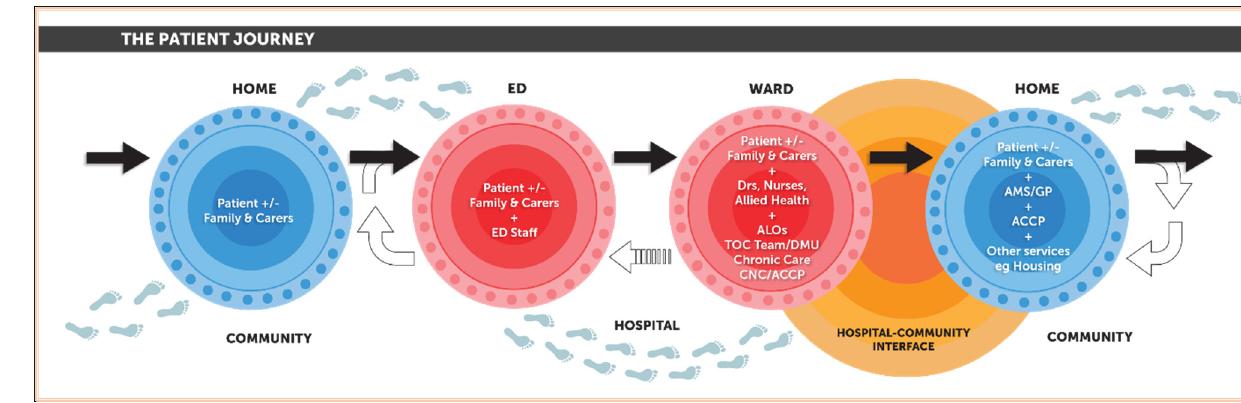
Figure 1. ATOC patient journey. ACCP, Aboriginal Chronic Care Program; ALOs, Aboriginal Liaison Officers; AMS, Aboriginal Medical Service; CNC, Clinical Nurse Consultant; DMU, Demand Management Unit; Drs, Doctors; ED, Emergency Department; GP, General Practitioner; TOC, Transfer of Care.